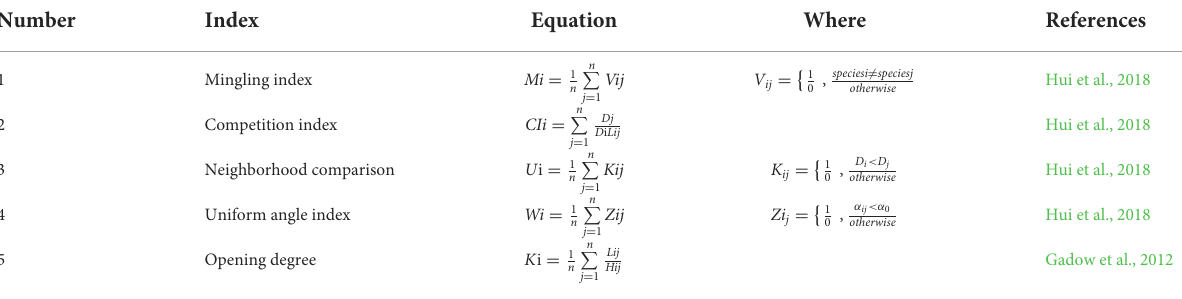
TABLE 2 Equations for calculating the spatial structure characteristic